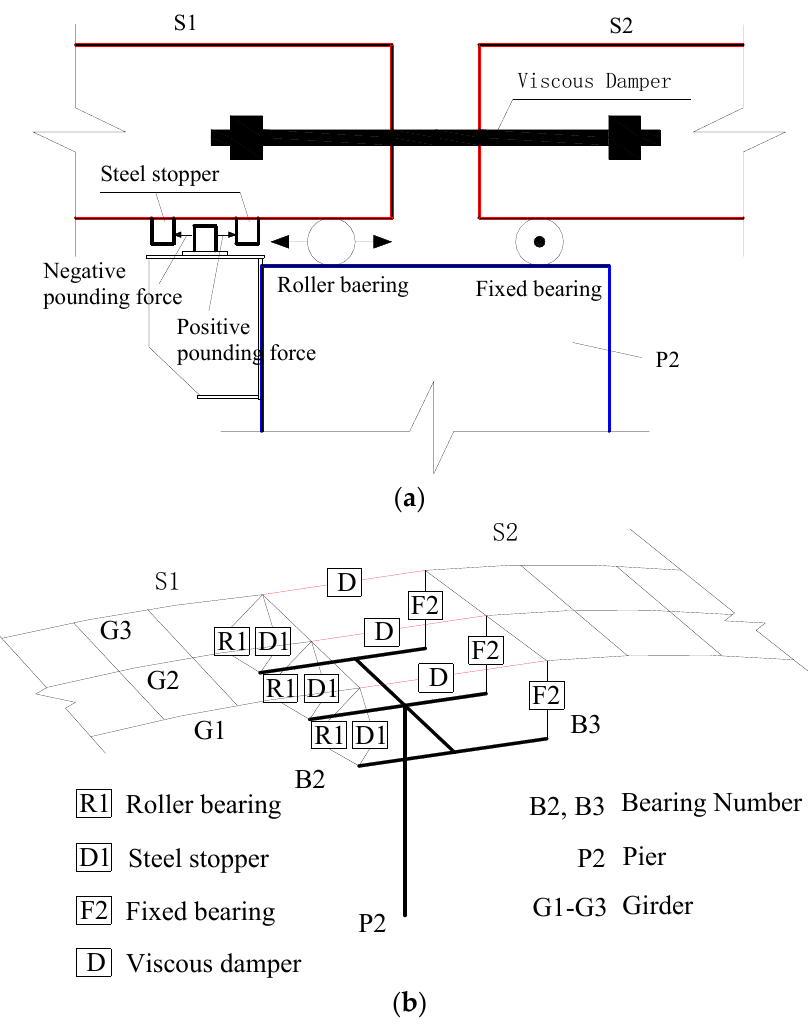
Figure 2. Analytical model of expansion joint. ( a ) Analytical model of expansion joint. ( b ) Finite element model of expansion joint.